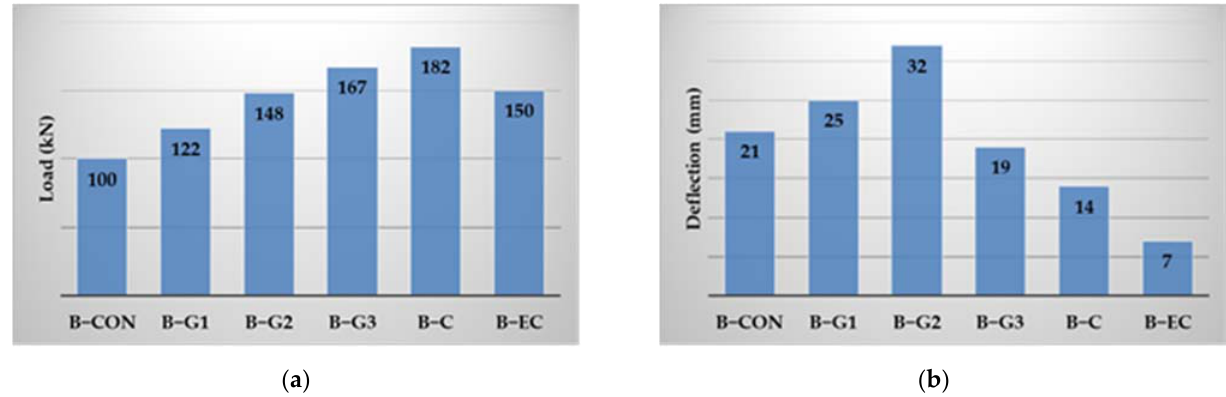
Figure 11. ( a ) Comparison of maximum load-bearing capacity of the tested beams; ( b ) Comparison of maximum deflections at half of the span of the tested beams.